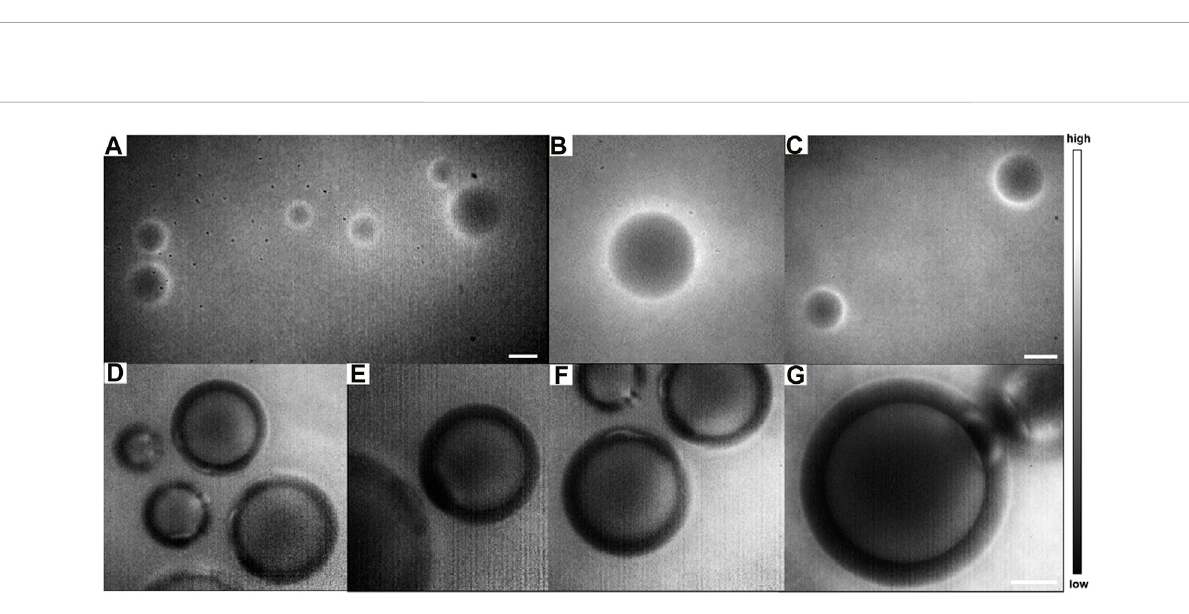
FIGURE 8 NIR-II fl uorescence microscopic images of ICG-stained E. multilocularis vesicles obtained from cultured protoscoleces in vitro on day 60 (A) in a large fi eldofviewundera×10objective and (B – C) bylocal magni fi cation. (D – E) Magni fi cation fi eldsof E. multilocularis vesiclespost-treatmentwith ICG under a (F) ×25 objective and (G) ×50 objective (scale bars: 100 μ m) under an 808 nm laser